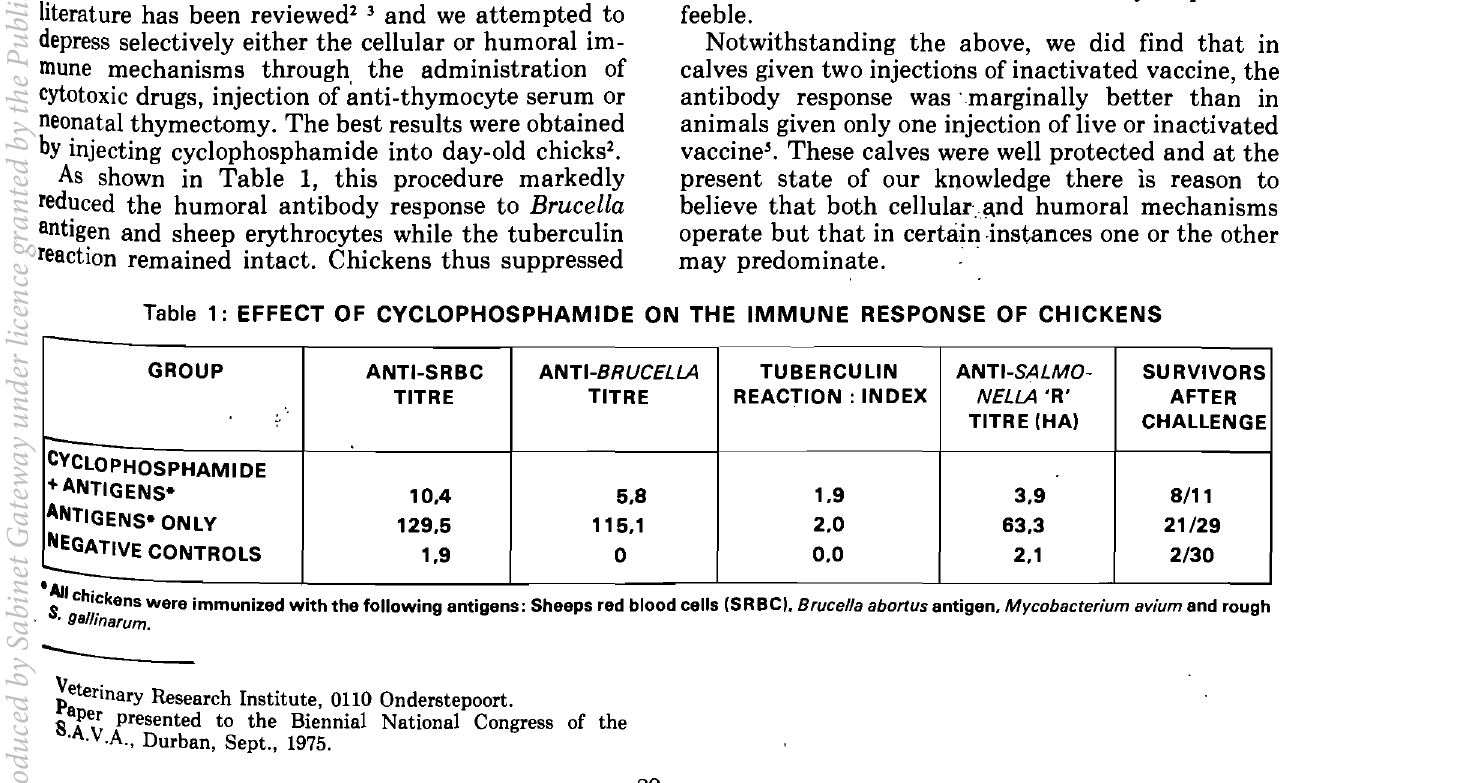
Table 1: EFFECT OF CYCLOPHOSPHAMIDE ON THE IMMUNE RESPONSE OF CHICKENS